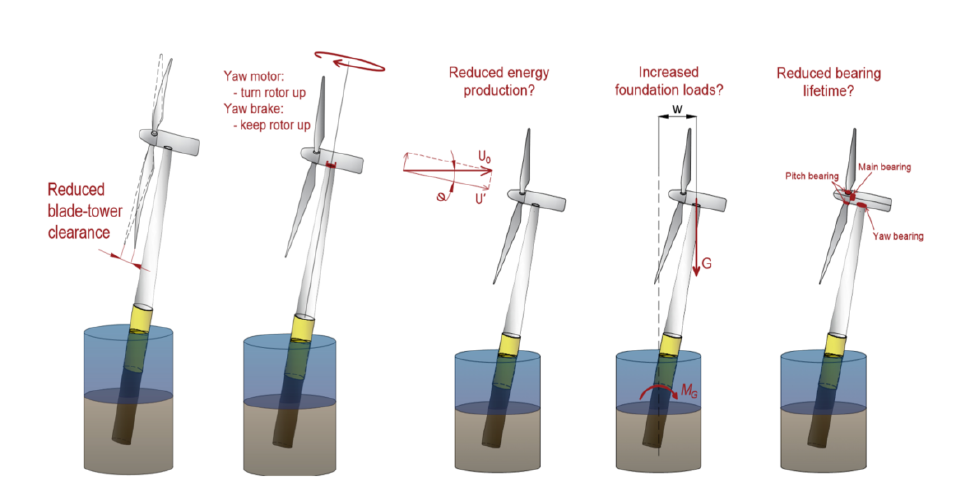
Figure 8. Design considerations governing the serviceability limit states (SLS) requirements for offshore wind turbine supported on a monopile foundation.